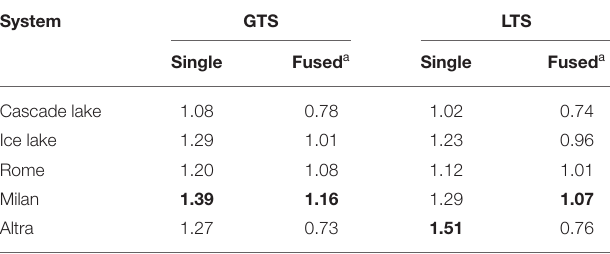
TABLE 5 | Sustained 32-bit floating point performance on the studied